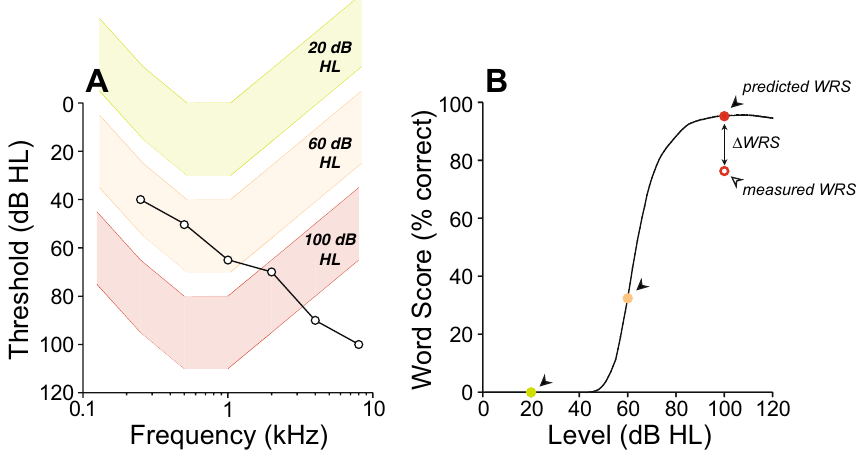
Figure 1. Illustration of the relationship between audiometric thresholds and the performance-intensity function for speech recognition (i.e., speech intelligibility curve). The speech intelligibility curve in ( B ) is drawn from the amount of speech material that is audible to a patient with a specific hearing loss ( A ) combined with a transfer function appropriate to the speech material. In ( A ), W-22 phonetically balanced words presented at either 20 dB HL (green), 60 dB HL (orange) or 100 dB HL (red). To index the loss of intelligibility in word recognition that cannot be accounted by a loss of audibility, we also calculated the difference between the measured word recognition score and the one predicted by the SIC in each patient ( B